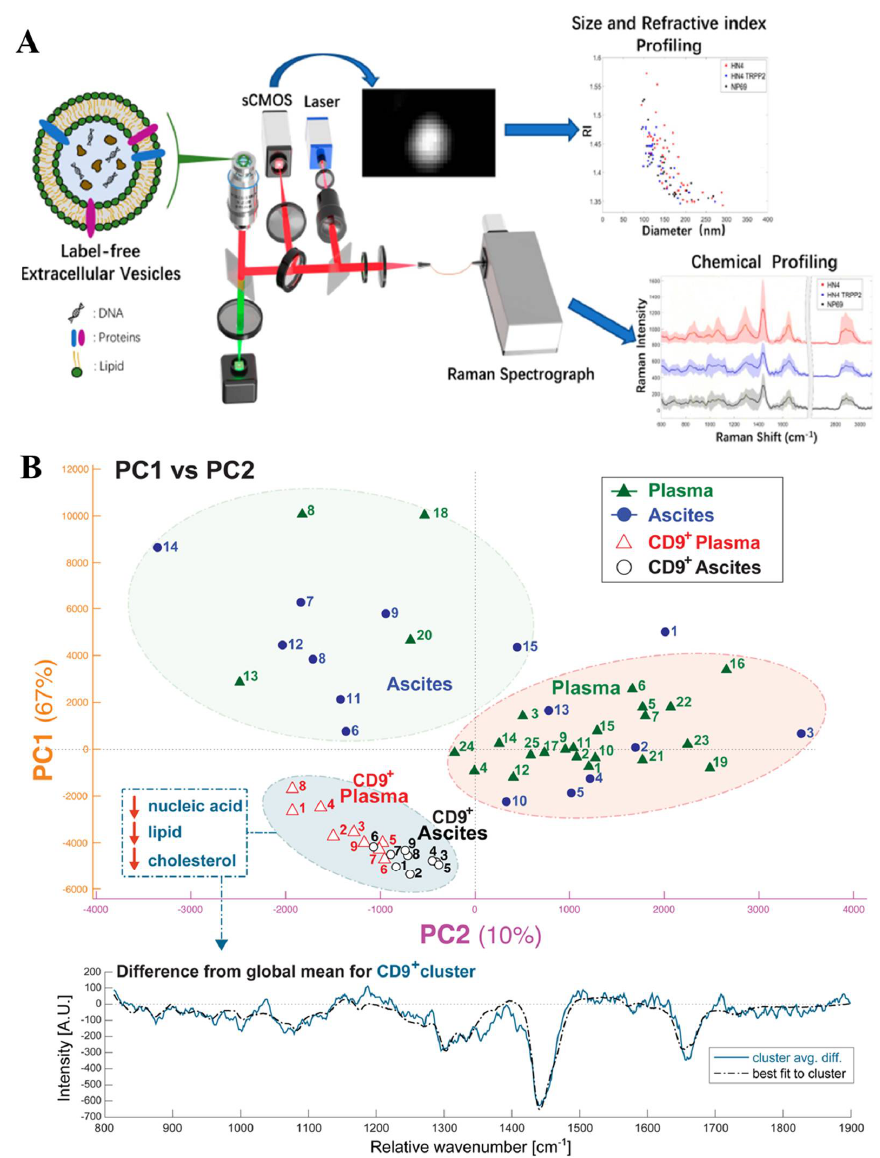
Figure 6. Raman-based methods for the single EV molecular analysis. ( A ) Raman−enabled nanopar- ticle trapping analysis (R−NTA) for the EV analysis, by using morphology and chemical information. Reprinted with permission from [65]. Copyright 2020, American Chemical Society. ( B ) A multispectral optical tweezers (MS−Ots) for the single vesicle molecular fingerprinting. Reprinted with permission from [66]. Copyright 2017, American Chemical Society.